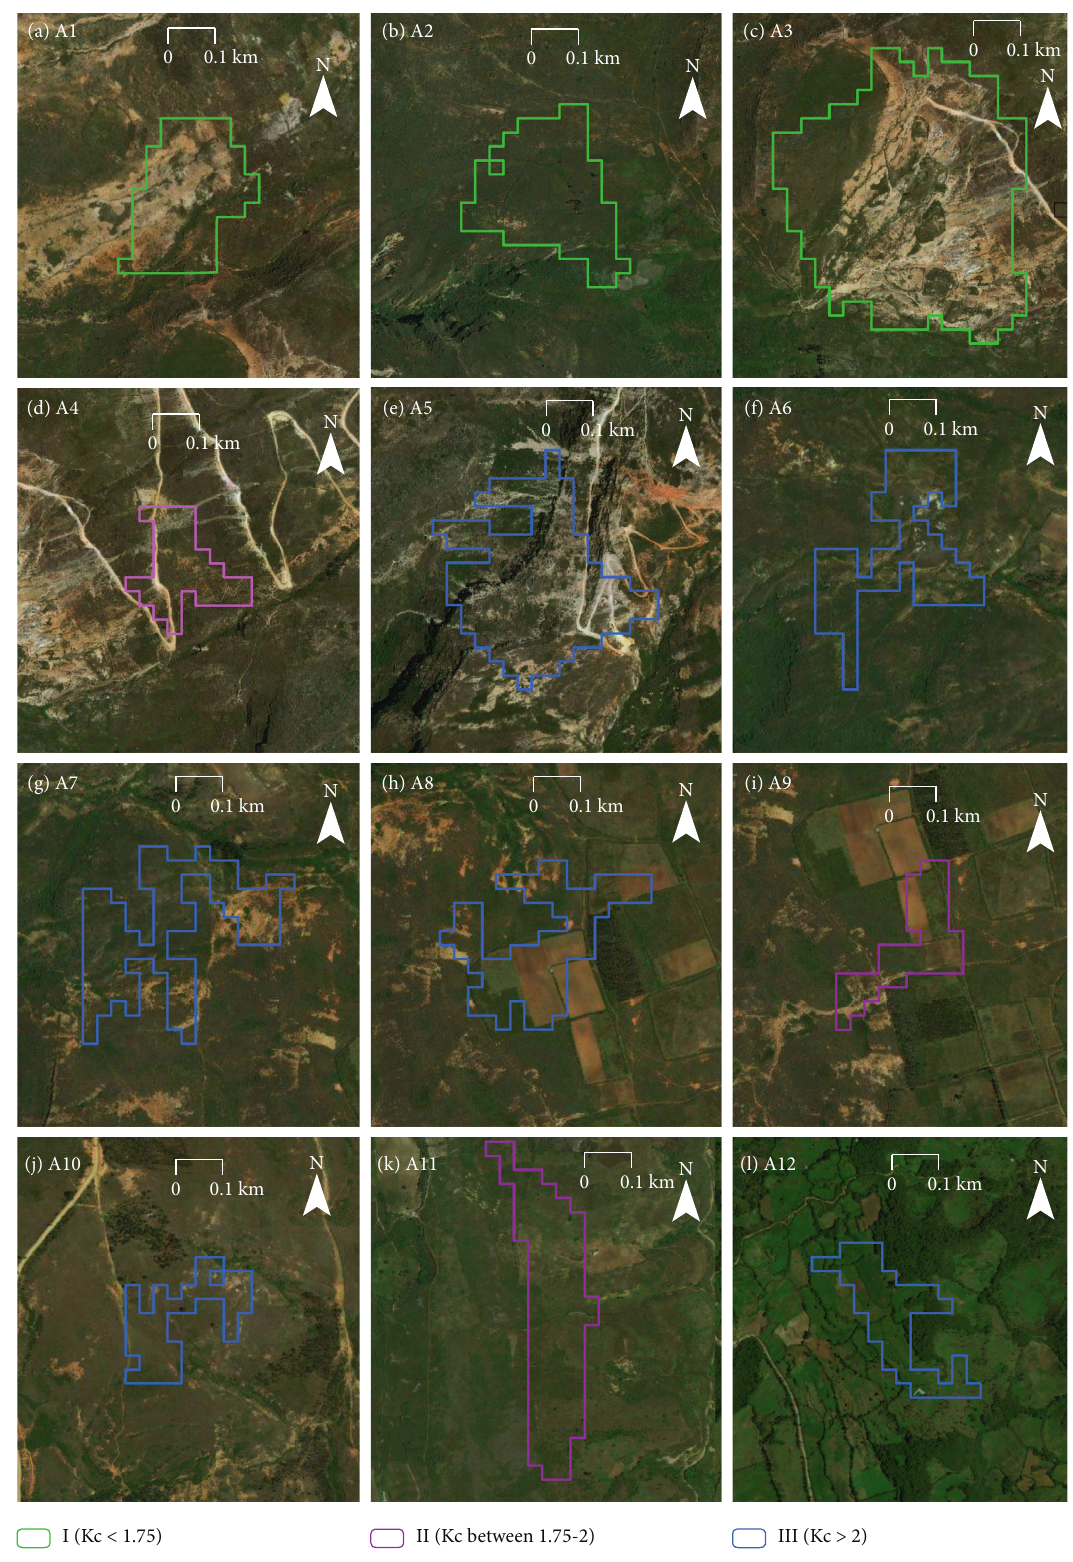
Figure 7: Satellite view of highly suitable sites for landfills. (a) A1. (b) A2. (c) A3. (d) A4. (e) A5. (f) A6. (g) A7. (h) A8. (i) A9. (j) A10. (k) A11. (l)